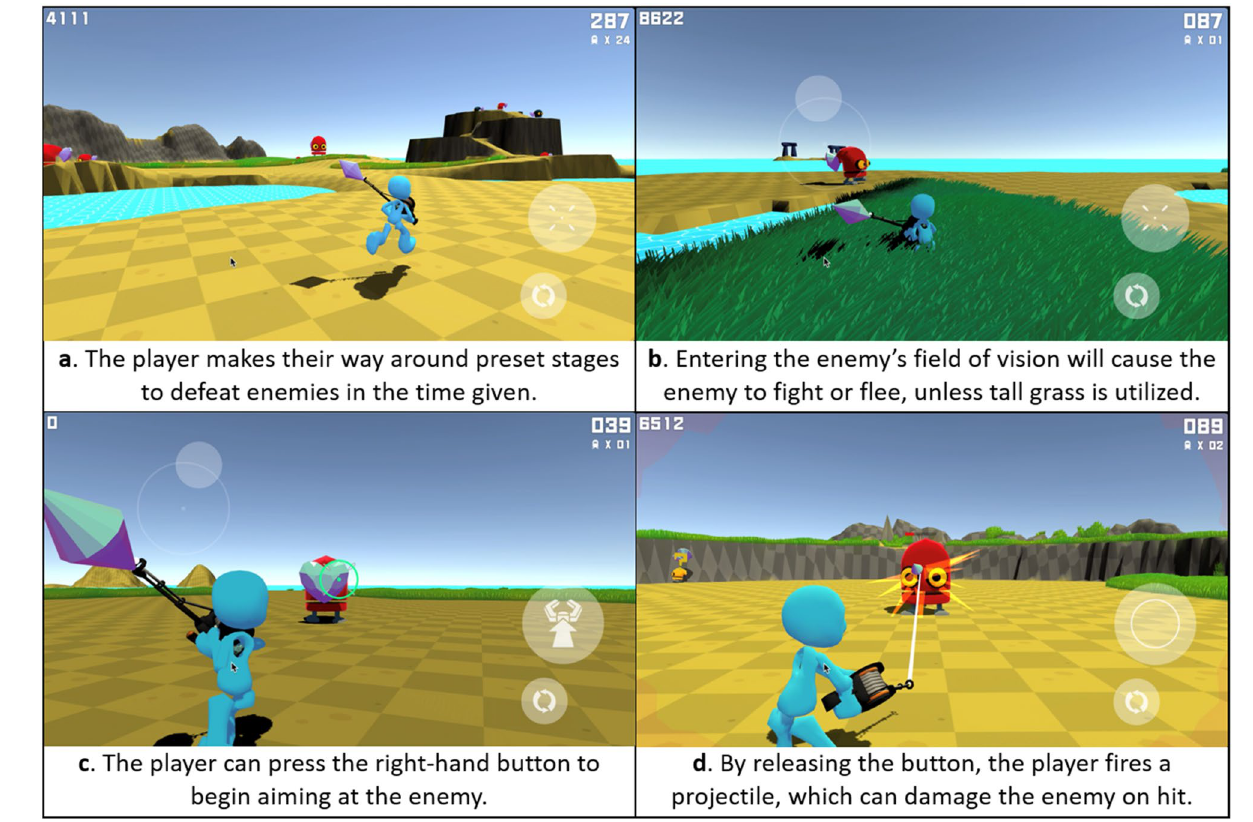
Figure 2. Diagram depicting common actions taken during gameplay, through screenshots of the prototype being played. How the player uses the user interface to move around and rotate the viewport to look in a specific direction ( A ) are used to calculate Input Multi-tasking. How the player utilizes stealth-assisting tall grass ( B ) is used to calculate Stealth Oriented Behavior. How long the player spends aiming ( C ) is used to calculate Bias Towards Aiming. Whether or not the player is successful in landing hits ( D ) is used to calculate Projectile Accuracy. These actions indirectly and directly aggregate into the player’s gameplay session Next, we examined whether gameplay performance significantly differs based on sociodemographic data, specifically across age and gender. We found that there is a pronounced gender disparity in Performance (with male players scoring higher than female players) both in the average Performance level and within each age group, and that the trend seen in Performance with increasing age group differs by gender. Specifically, the performance of female players is comparable between those in their teens, twenties, and thirties, with a sharp drop-off in performance in their forties, while for men, the sharp drop-off in performance happens between players in their forties and fifties, approximately a decade later than the trend with female players. A similar trend was found in participant’s self-rated affinity for action games and recent video game exposure. For men, we categorized all those under the age of 50 into the younger group, whereas for women we categorized all those under the age of 40 into the younger group, resulting in N = 100 participants in the younger group and N = 54 participants in the older group. Figure 4 displays the model-fitted performance for each gender and age group, computed from the final model (Model 8) as seen in Table 2. Post-hoc generalized linear model tests indicated significant difference between genders (t = 4.241, p < 0.001) and age group (t = 2.242, p = 0.026). The difference between young men and old women was significant (t = 5.595, p < 0.001), but not between old men and younger women (p = 0.951). Figure 3 depicts the distribution of performance scores for players in each age group. Regressing performance to age (Model 1), then to both age and gender (Model 2) confirms that being younger